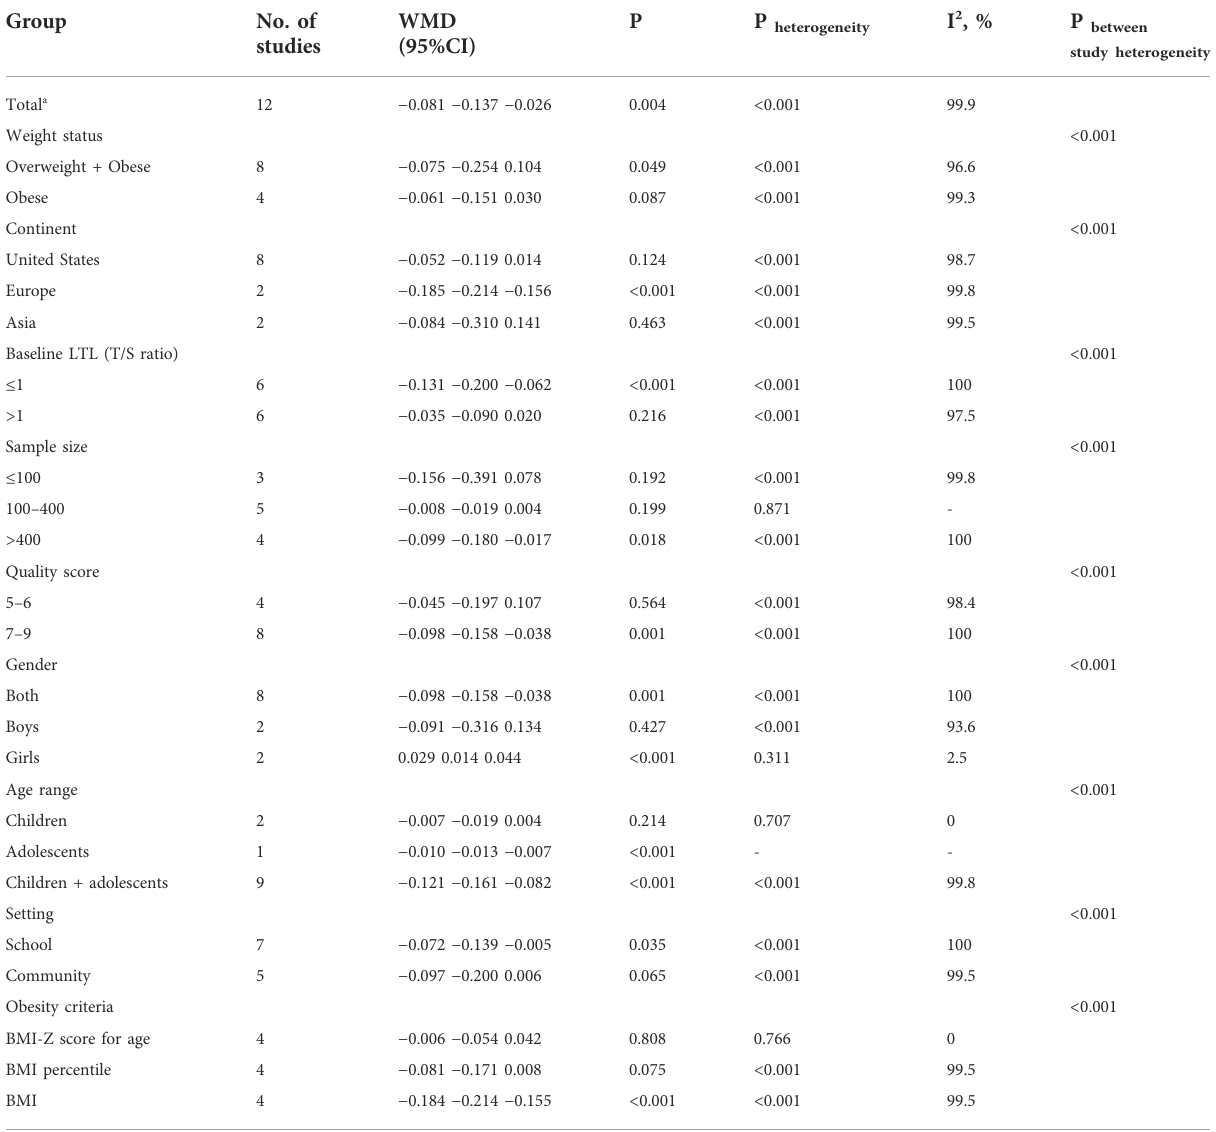
TABLE 4 Results of subgroup analyses of the comparison of leukocyte telomere length (LTL) in overweight/obese versus non-overweight/obese youth.